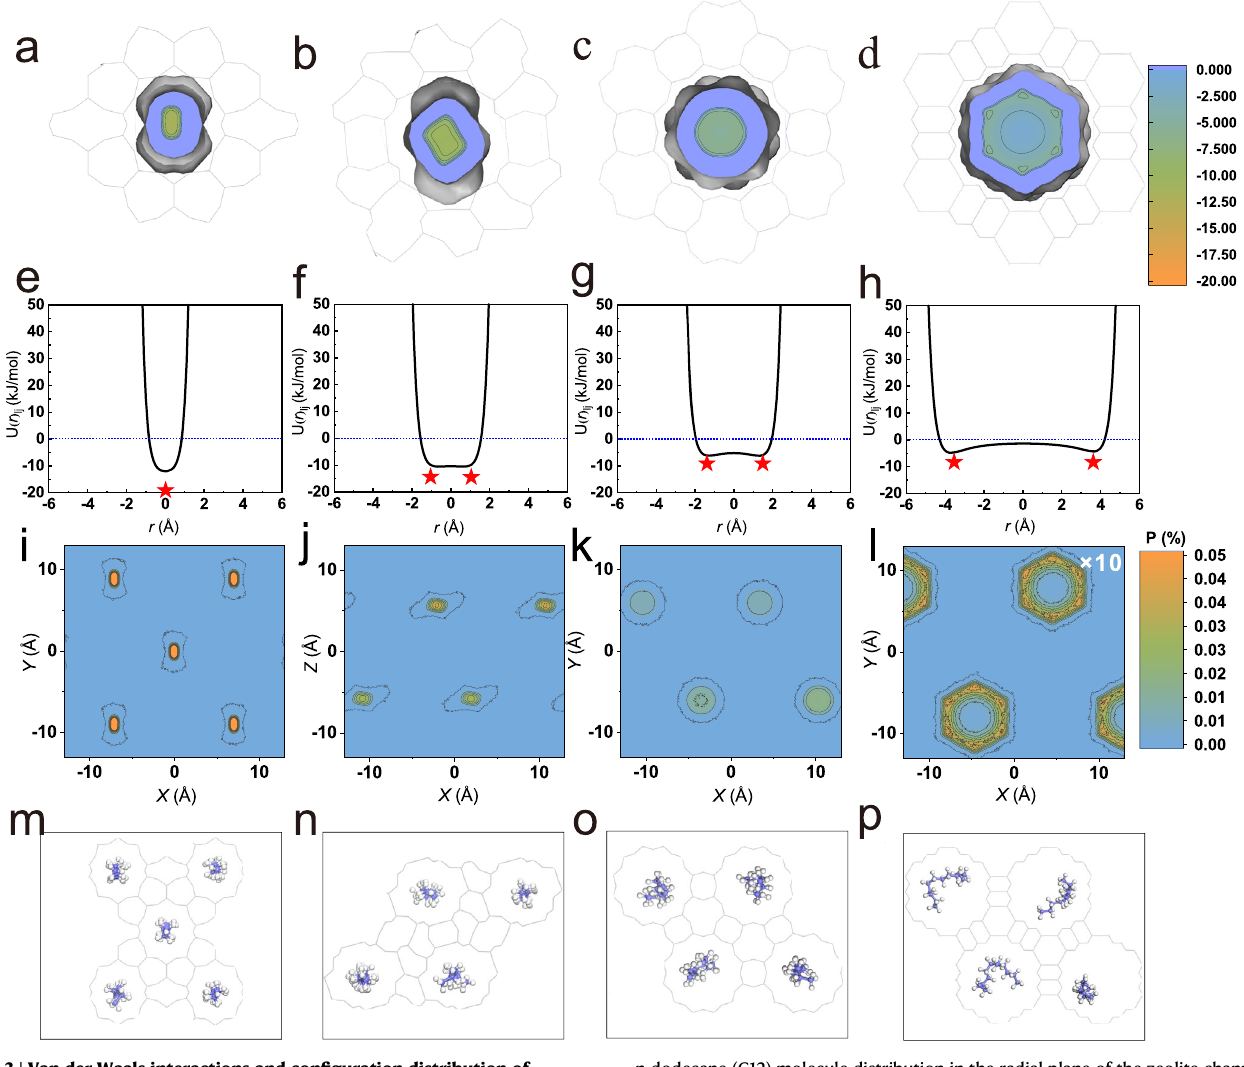
n-dodecane (C12) molecule distribution in the radial plane of the zeolite channel. m – p Correspondingstructurediagramofarandomframeofn-dodecanediffusion in zeolite, with TON, MTW, AFI, and VFI zeolite from left to right (purple and white spheres represent the carbon and hydrogen